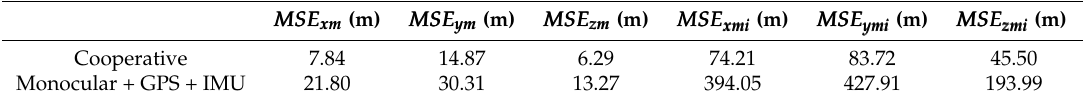
Table 5. Total mean squared error in: (i) the position estimation of the landmarks ( MSE xm , MSE ym , MSE zm ); and (ii) the initial position estimation of the landmarks ( MSE xmi , MSE ymi , MSE zmi